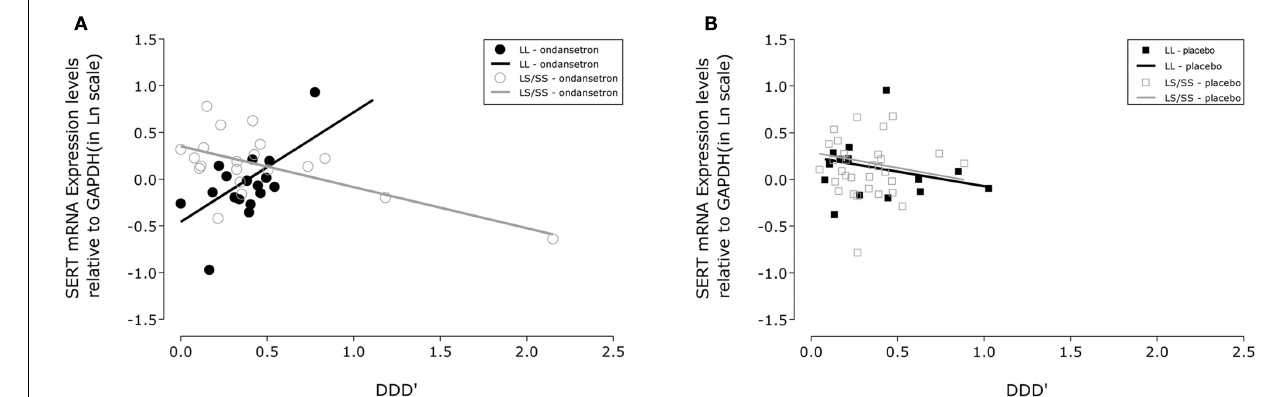
severity in LL subjects; the open symbols and light lines represent the corresponding changes in LS/SS subjects.The intercepts and slopes for expression levels in the LL and LS/SS ondansetron groups were estimated from a linear mixed-effects model: y =− 0.4566 + 1.1698 × x and y = 0.3524 − 0.4385 × x , respectively.The corresponding estimates for the LL and LS/SS placebo groups were y = 0.2417 − 0.3150 × x and